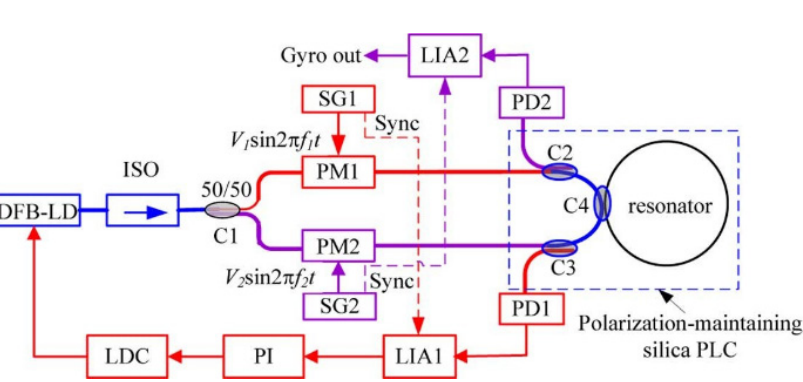
Figure 4. The configuration of the SPMT using the sinusoidal wave. DFB-LD: distributed feedback laser diode; ISO: isolator; LDC: laser diode controller; Sync: synchronization signal. Reprinted with permission from ref. [13]. Copyright 2011